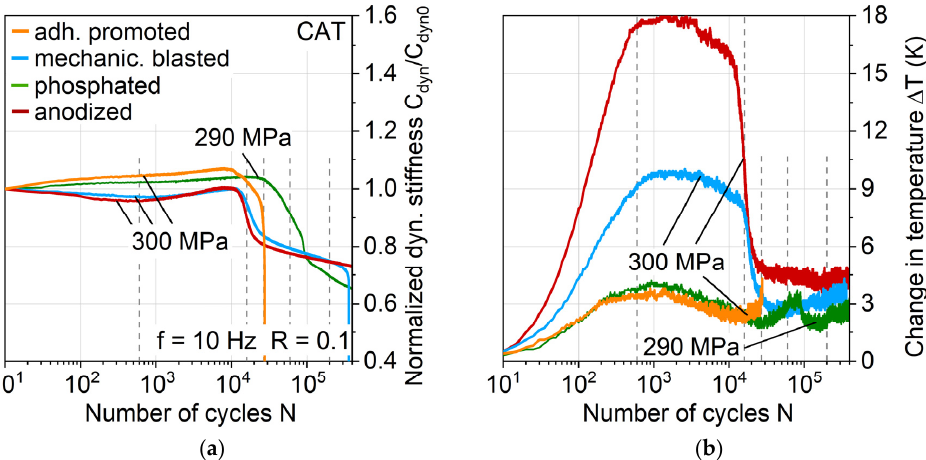
Figure 14. Influence of aluminum surface treatment on ( a ) normalized dynamic stiffness and ( b ) change in temperature (plotted logarithmically) during constant amplitude tests; dotted indicator lines for cycles of hysteresis investigation.